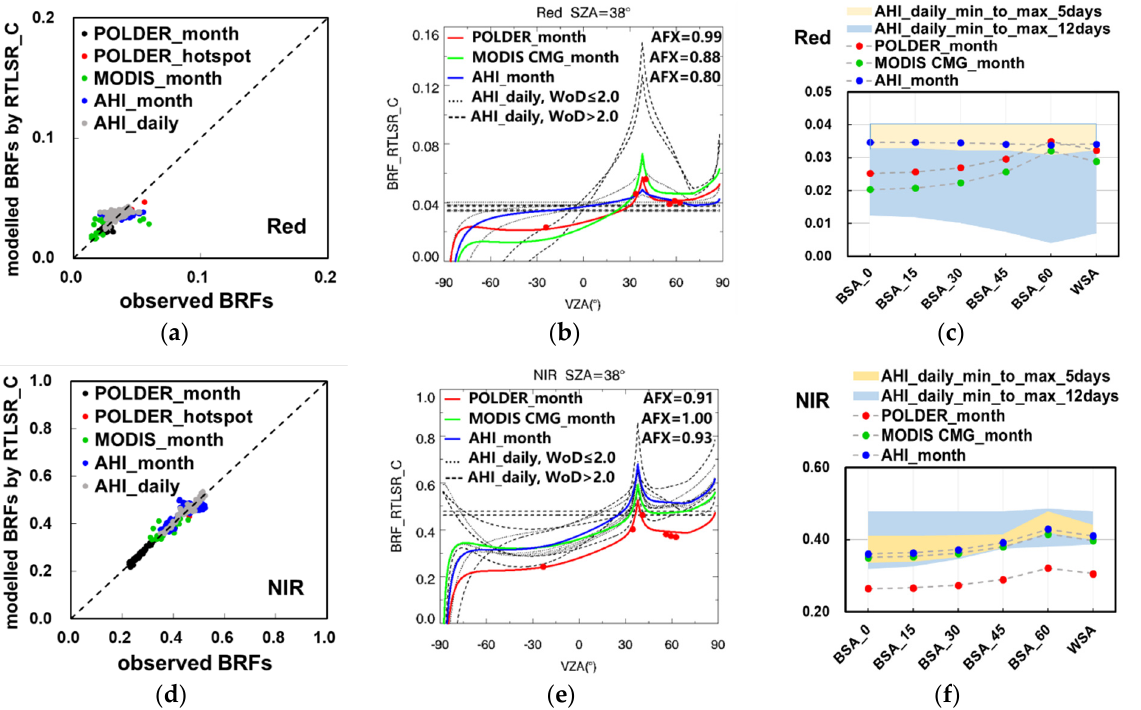
Figure 6. Comparison of bi-directional reflectances and albedos between the RTLSR_C-modelled results and observations from POLDER, MODIS, and AHI at a mixed forest pixel. ( a – c ) present comparisons of the modelled and observed bi-directional reflectances (i.e., BRFs) in the red band for all observation geometries and principal plane, as well as comparisons of BSA and WSA, respectively. The red dots in ( b ) refer to observations near the principal plane, and the two observations with VZAs that are close to the SZA of 38° are hotspot data. BSA_0 in ( c ) refers to the BSA when the SZA is zero (nadir), and BSA_15, BSA_30, BSA_45, and BSA_60 refer to the BSAs for SZAs of 15°, 30°, 45°, and 60°, respectively. ( d – f ) refer to the results that are similar to ( a – c ) but in the NIR band.